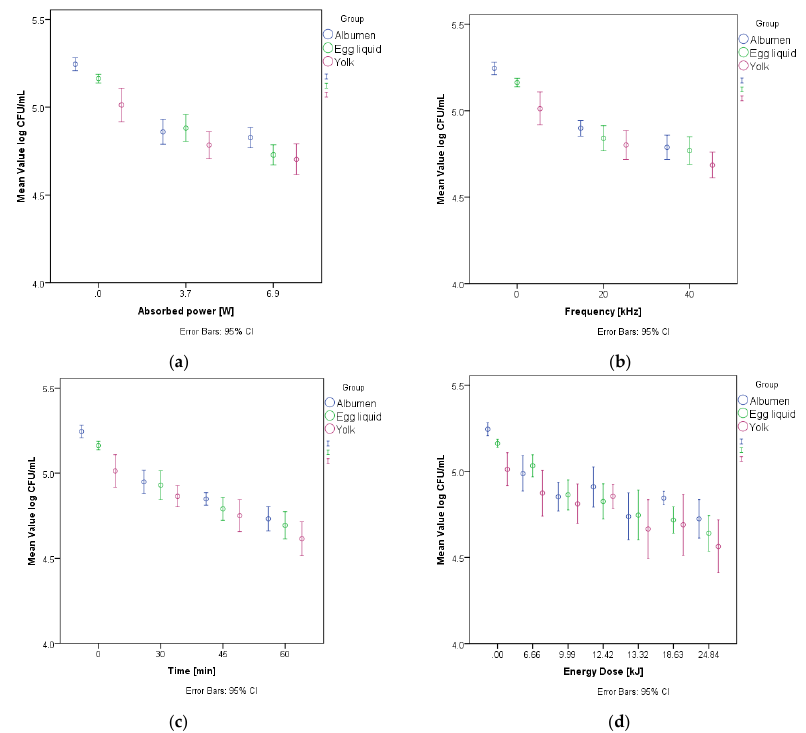
Figure 4. Log colony-forming unit (CFU)/mL decrease by absorbed power ( a ), frequency ( b ), time ( c ) and energy dose ( d ) for all